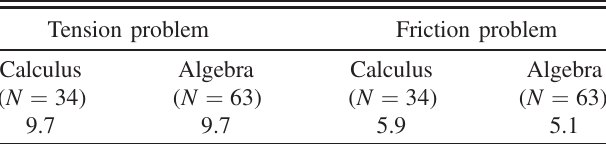
TABLE VIII. Average scores out of 10 points on the tension problem (reproduced after returning its solution) and the friction problem for intervention 1 in the calculus-based and algebra- based